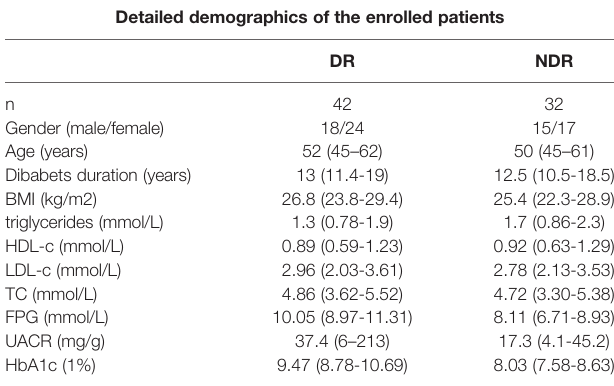
TABLE 1 | Detailed demographics of the enrolled